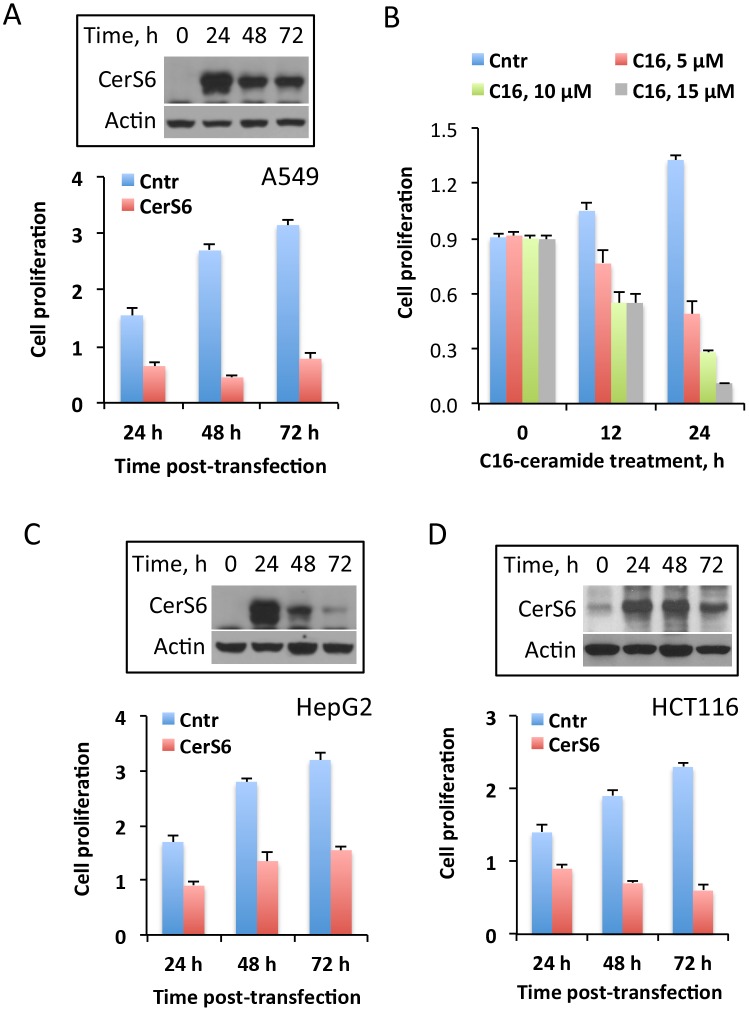
The effect of CerS6 transient expression on cancer cell lines highly sensitive to MTX.(A) Transient expression of CerS6 in A549 cells inhibits proliferation. (B) Antiproliferative effect of C16-ceramide on A549 cells. Live cells were assessed by MTT assay after exposure to C16-ceramide for indicated time; stock solution of ceramide (10 mM) was prepared in 50:50 mixture of DMSO/methanol and was added directly to cultured cells; control cells were treated with the same volume of DMSO/methanol mixture. Error bars show SD of four measurements. Differences between control and drug treated groups were statistically significant (calculated by one-way ANOVA) with p value below 0.0009. (C and D) Transient expression of CerS6 in HepG2 or HCT116 cells inhibits proliferation. For panels A, C, and D cells were transiently transfected with the CerS6 expression vector and proliferation was assessed by MTT assay at indicated time points. Data from MTT assay are plotted as fold change of live cells compared to control (number of cells at 0 h). Data show average of a representative experiment, six measurements for each data point, with error bars indicating SD; Student’s t test was performed for statistical analysis (in all data sets the difference between control and CerS6-transfected cells were statistically significant with p<0.005). Insets show levels of CerS6; actin was used as a loading control.